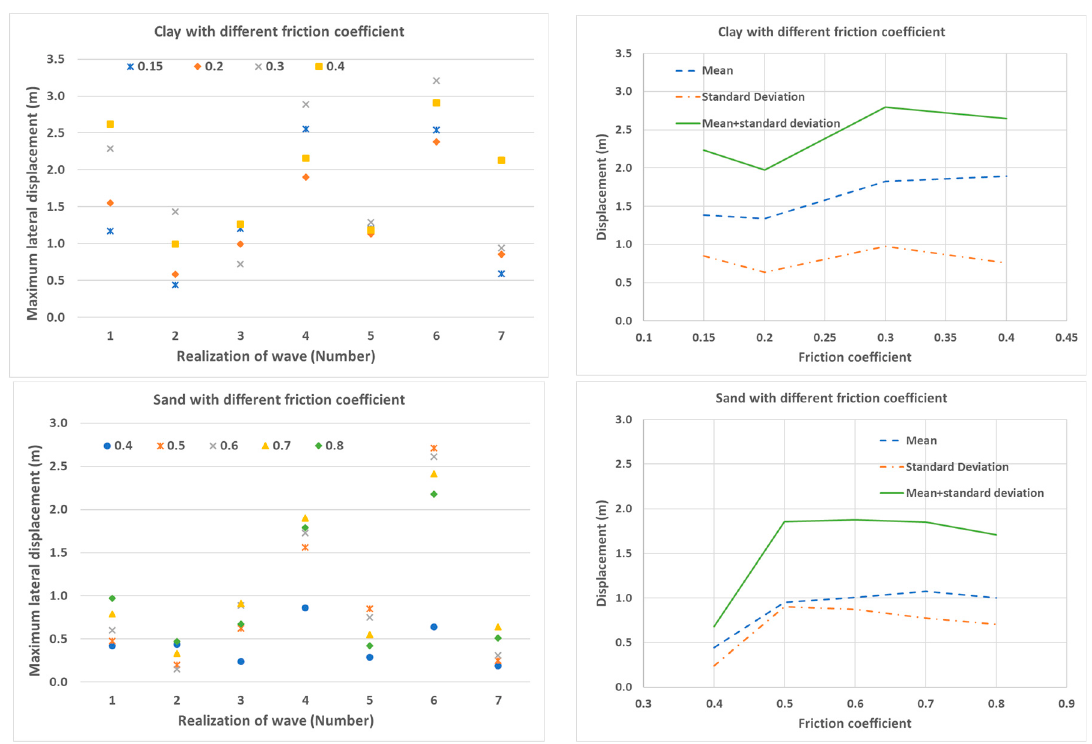
Figure 8. The lateral displacement of the umbilical for seven wave realizations and the mean and standard deviation of the lateral displacement (with different friction coefficients).